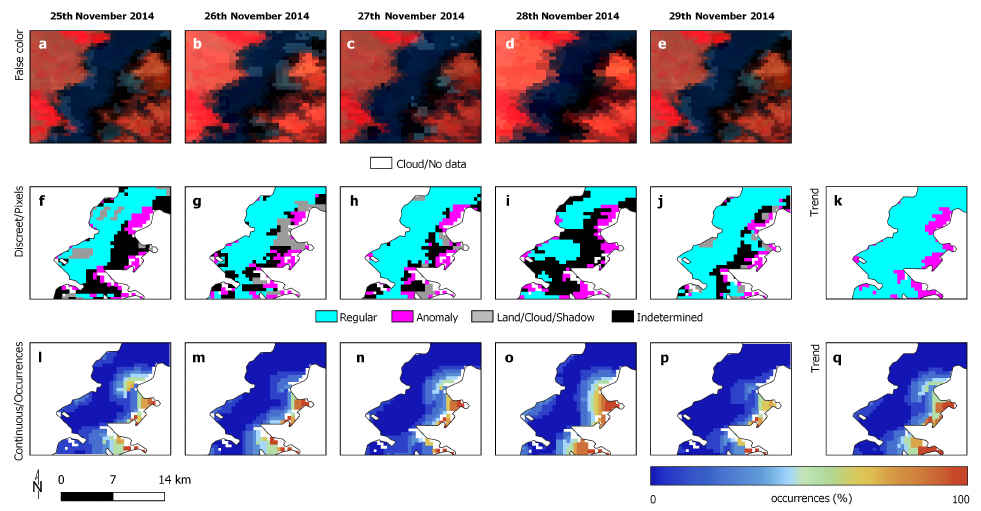
Figure 8. Images ( a – e ) in false-color composition (NIR, red and green bands) for the Lake Chilika study area from 25–29 November 2014. Regular, anomaly, land/cloud/shadow and indeterminate samples ( f – j ) are identified by cyan, magenta, gray and black polygons, respectively; ( l – p ) show the local anomaly concentration at each instant; ( k , q ) represent the discrete and local anomaly concentration references for the whole forecasting period.